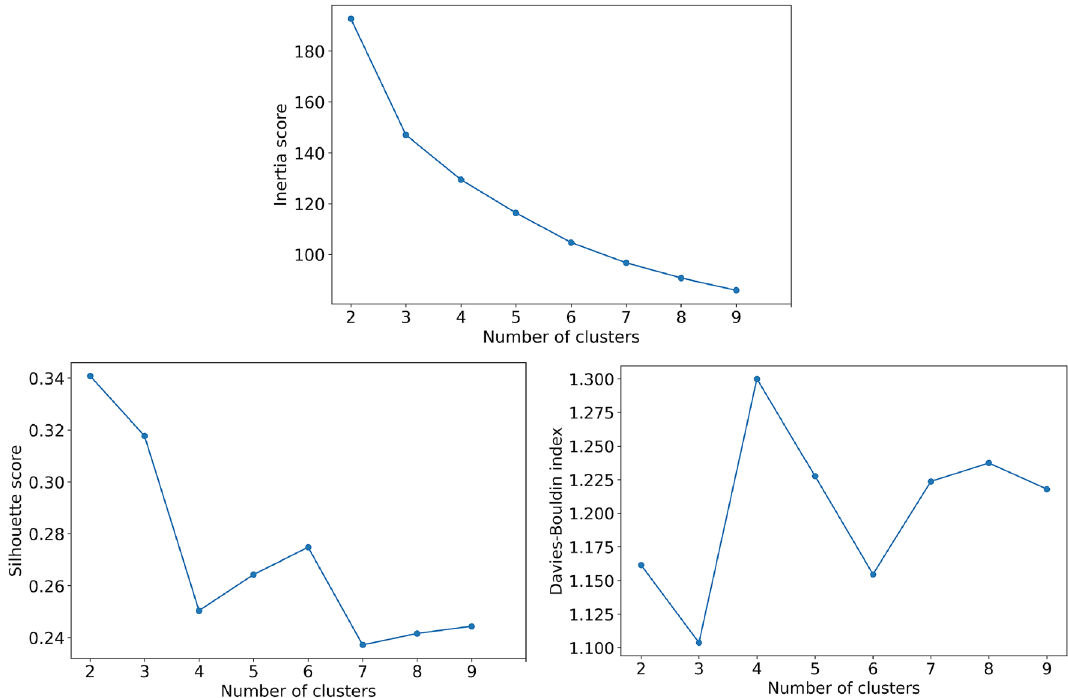
Figure 2. Evaluation results based on Inertia score, Silhouette score, and Davies–Bouldin index.